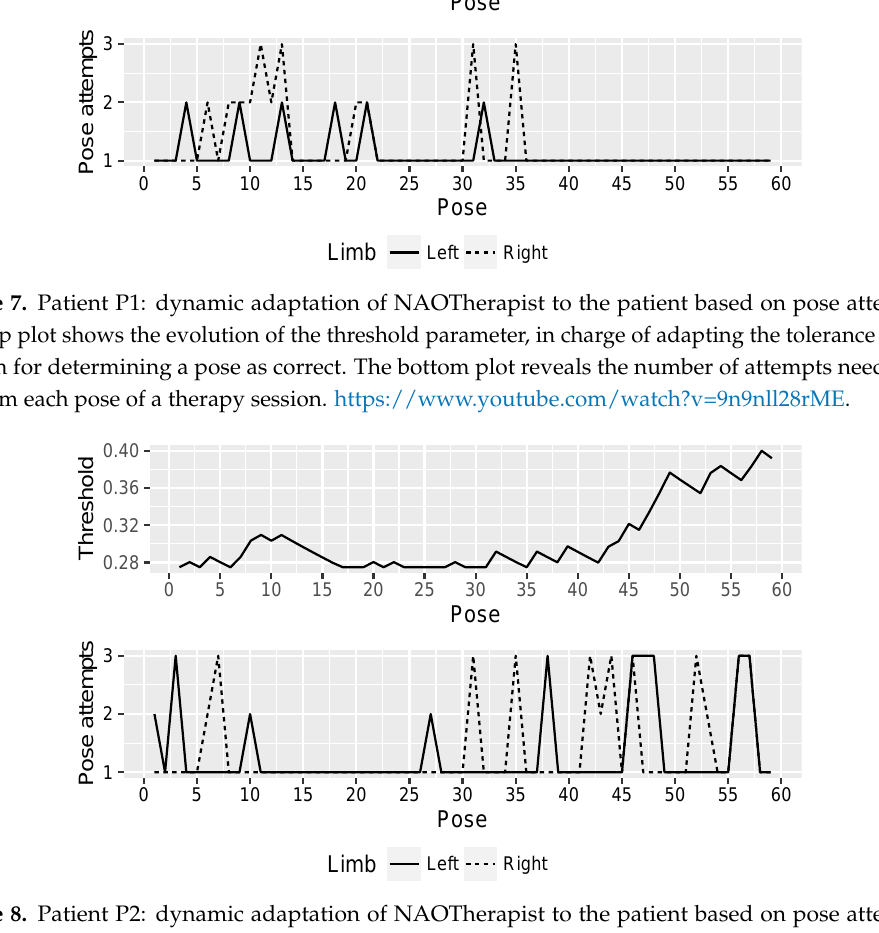
Figure 8. Patient P2: dynamic adaptation of NAOTherapist to the patient based on pose attempts.